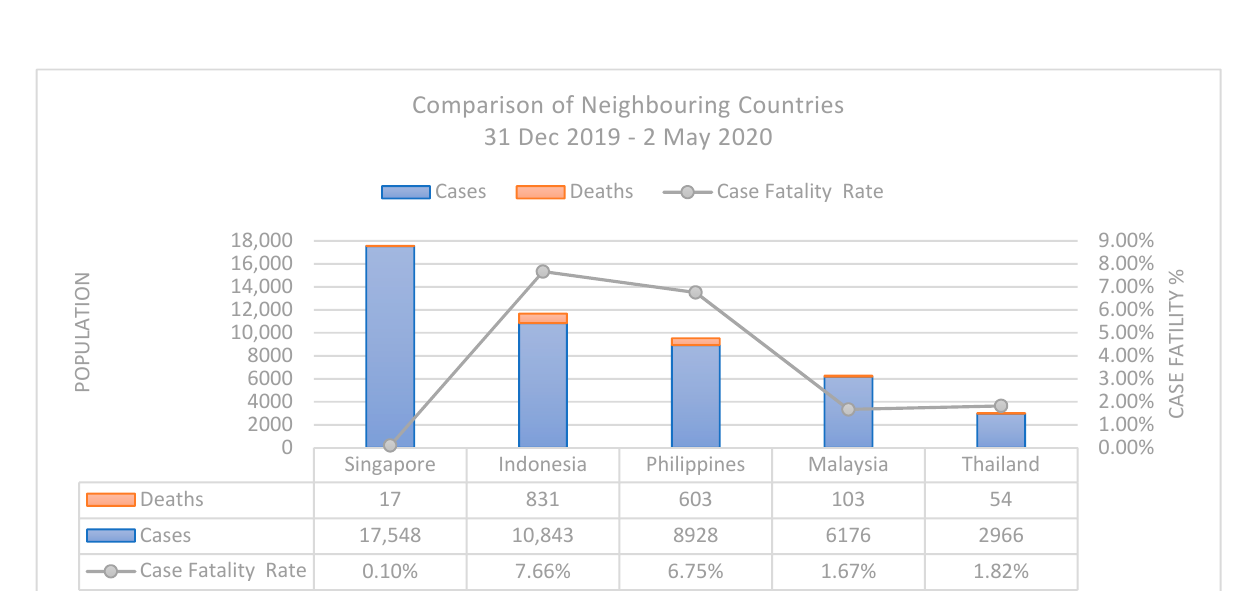
Figure 2. Country Comparison of confirmed cases, deaths and Case Fatality Rate (CFR) reported between 31 December